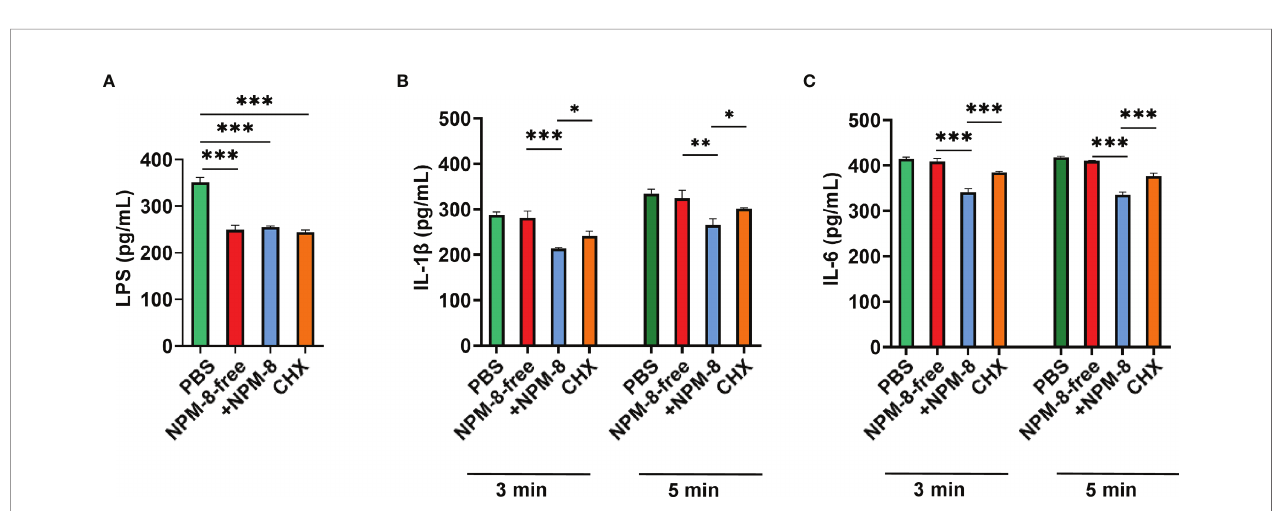
FIGURE 5 | Anti-in fl ammatory activity of the four test agents. (A) Quanti fi cation analysis of the LPS produced by P. gingivalis after the test agent treatment. (B) Quanti fi cation analysis of the proin fl ammatory cytokines IL-1 b in HGE cells stimulated with P. gingivalis supernatant and subsequently treated with test agents for 3 or 5 min. (C) Quanti fi cation analysis of the proin fl ammatory cytokine IL-6 in HGE cells stimulated with P. gingivalis supernatant and subsequently treated with test agents for 3 or 5 min. Data are presented as the means ± SD. * P < 0.05, ** P < 0.01, *** P <